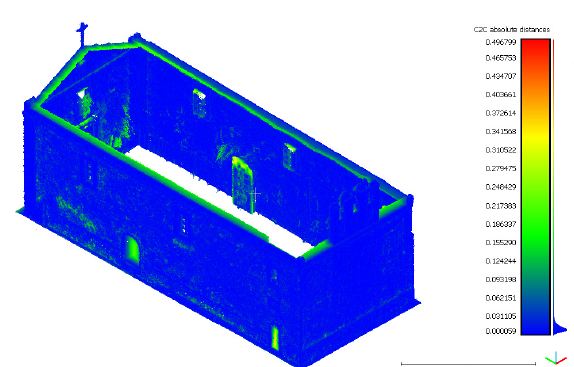
Figure 16. Absolute distances (in meters) between terrestrial laser scanner and UAV photogrammetric point clouds for the external part of the Saint John Church.